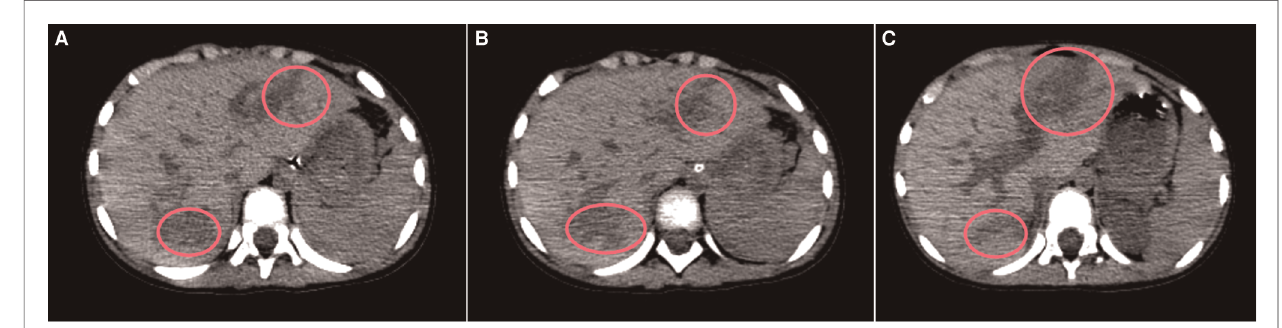
FIGURE 1 | Plain CT scan (liver window A to C ) showing irregular low-density lesions (pink circles) in SIVA and II, AAST Grade IV laceration and SVI, and AAST Grade III